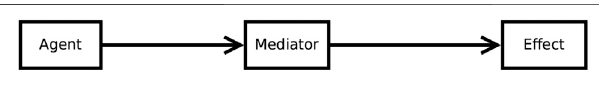
FIGURE 3 | The causal model for the Lindberg accountability pattern; the principal is not part of the pattern. Taken from Kacianka et al.